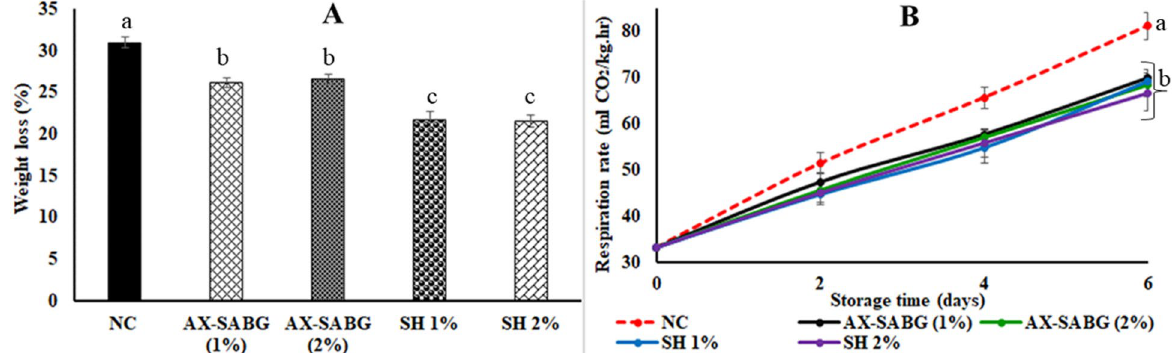
Figure 1. (A) Change in weight loss (%) and (B) respiration rate (ml/CO 2 /kg h) of peaches during storage ( NC uncoated, AX‑SABG arabinoxylan-β-d-glucan stearic acid ester, SH shellac). Data were analysed using ANOVA followed by Tukey’s multiple comparisons tests. The letters compare changes between the treatments. Different letters indicate significant differences at p <